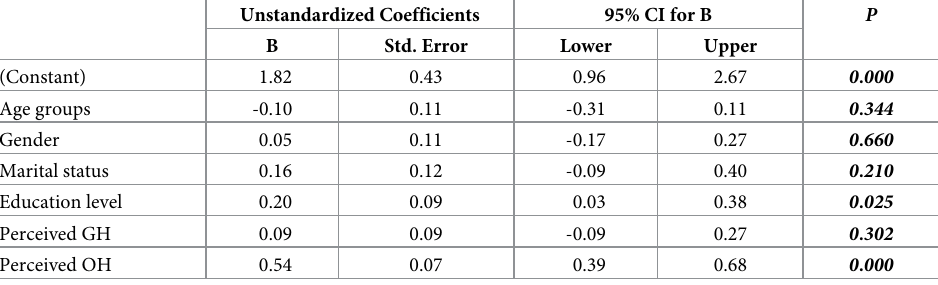
Table 6. Regression analysis for the determinants affecting the perception of orofacial